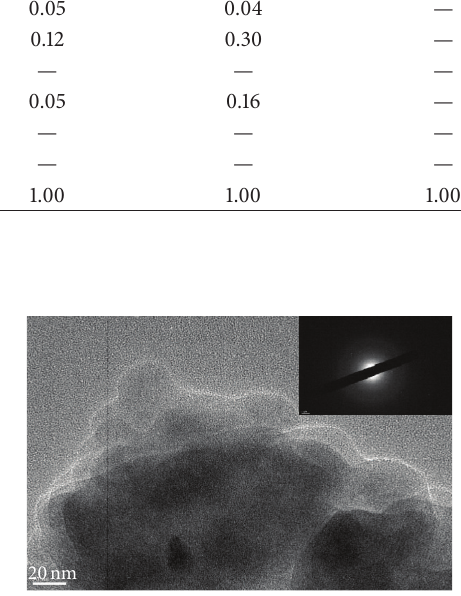
from both wood meal/Fe 3 O 4 (1 : 1 w/w) and wood meal/TiO 2 (1 : 1 w/w) samples pyrolyzed at 500 ∘ C, while the ratio